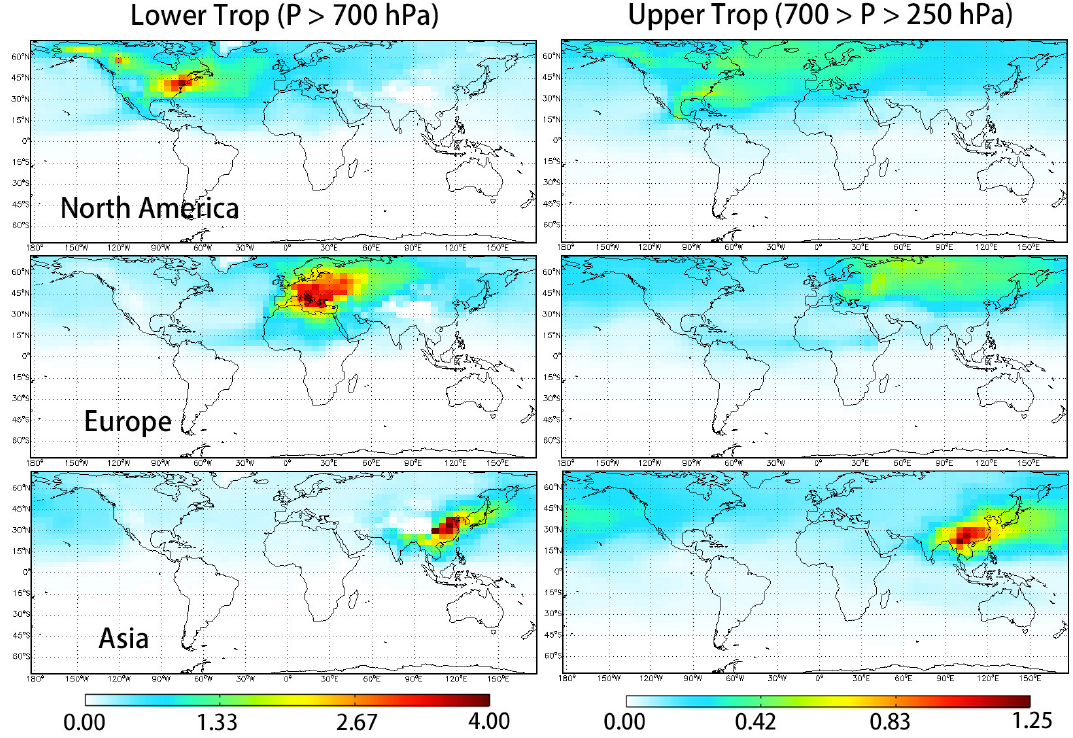
Figure 5. 30-day tracer partial columns in the extratropics for June 2004. The unit is 10 18 moleccm − 2 . Note the difference in scales between the lower and upper tropospheric columns.